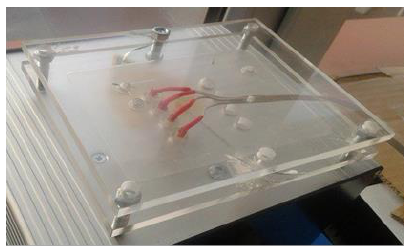
Figure 5. The photo of construction with four electrodes for the measurement of electrical re- sistance of textiles by the four-point method. of textiles by the four-point